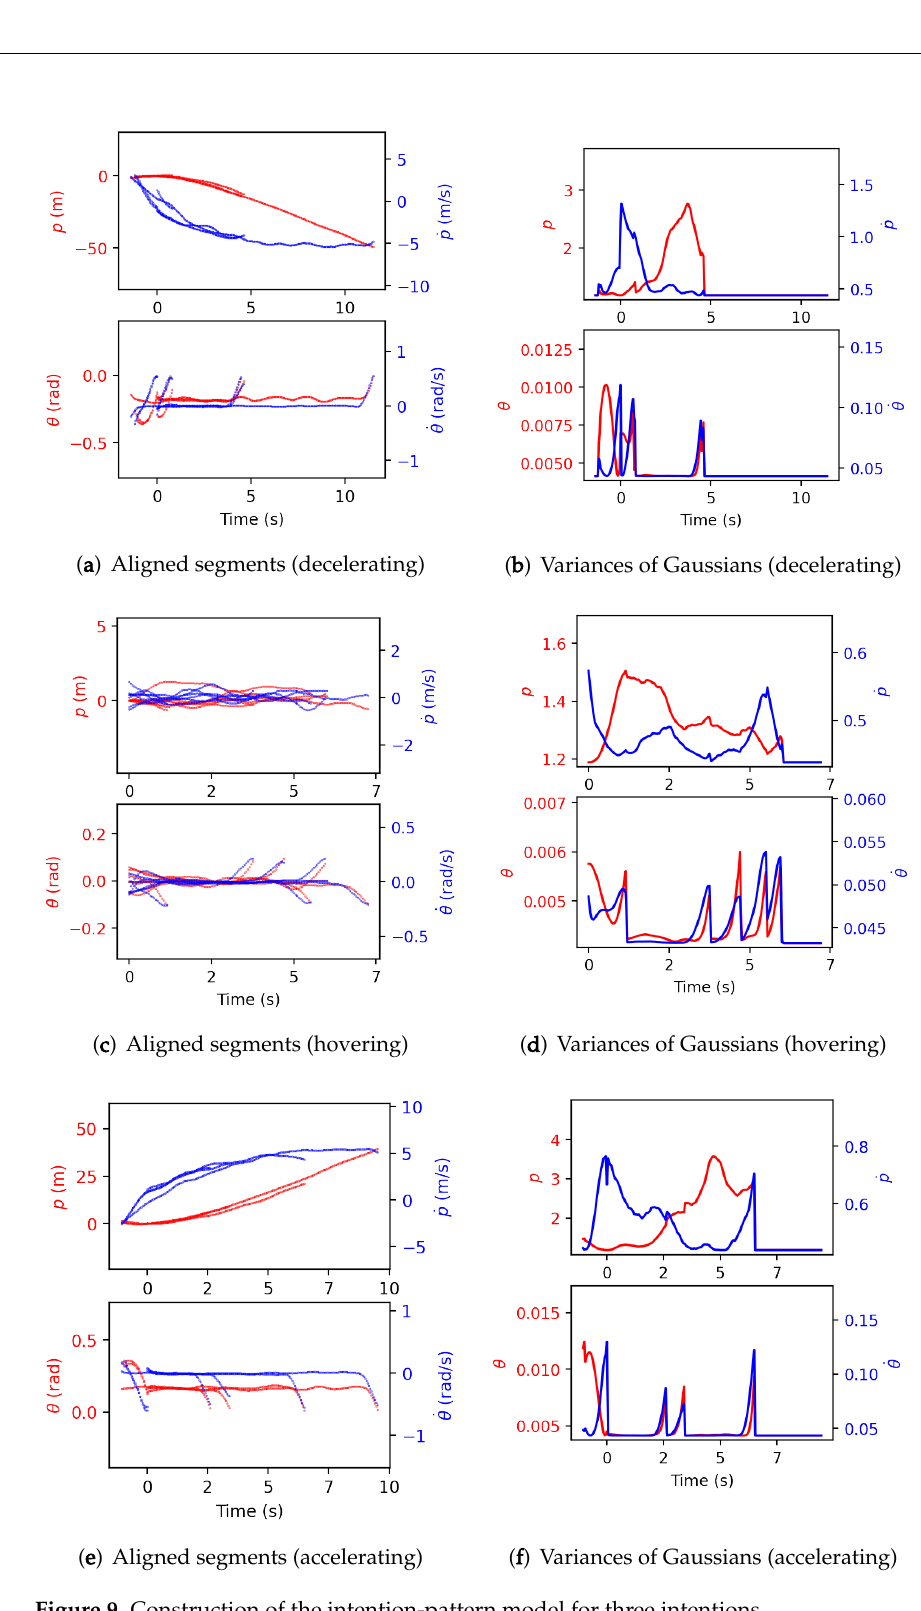
Figure 9. Construction of the intention-pattern model for three intentions.